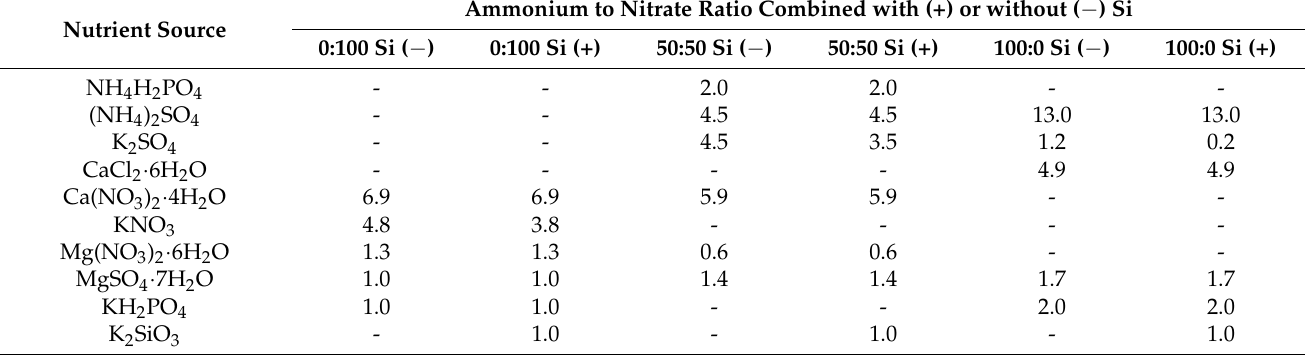
Table 1. Compositions of the nutrients (in me · L − 1 ) for the treatment solutions used in this study. Nutrient